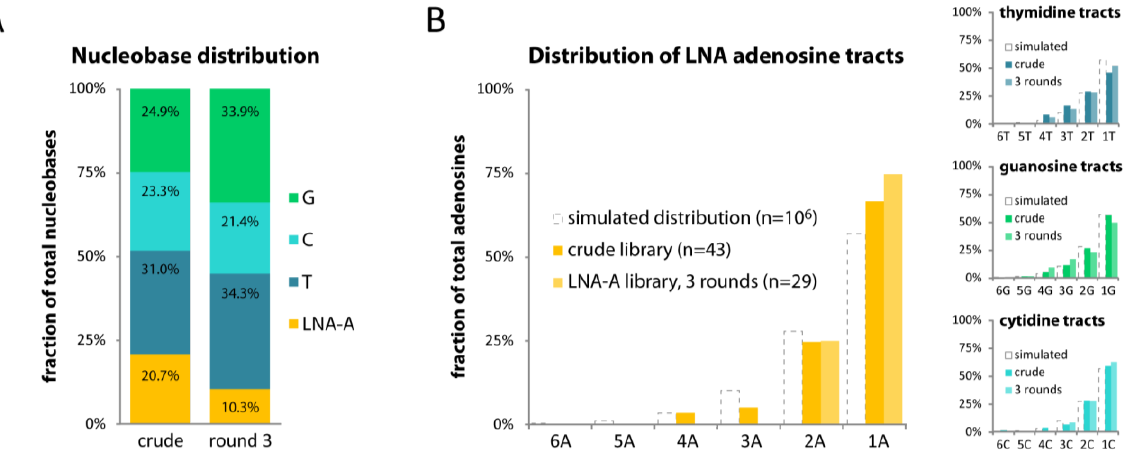
Figure 3. ( A ) Nucleobase distribution in the library’s 40-mer randomized region before and after being maintained with LNA ATP for three rounds of mock in vitro selection; ( B ) The distribution of homopolymer tracts of each nucleobase in the randomized 40-mer region in the crude DNA library or after three cycles of mock in vitro selection using LNA ATP. Dotted bars indicate the reference distribution of tract lengths as obtained from simulating 1 million random 40-mer